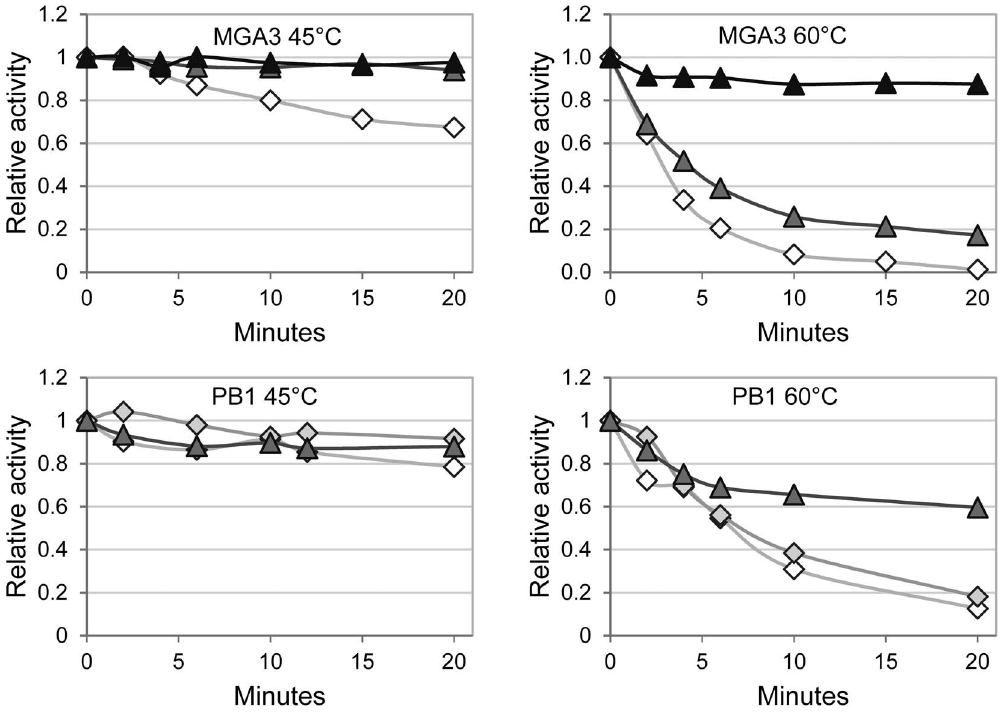
Figure 3. Temperature stability of the MGA3 and PB1 Mdhs. Enzymatic activities of Mdh M /Mdh P (white diamond), Mdh1 P (light grey diamond), Mdh2 M /Mdh2 P (dark grey triangle) and Mdh3 M (black triangle) were measured upon preincubation at 45 u C or 60 u C. Activity without preincubation was for each enzyme arbitrarily set to 1. The results from at least two independent experiments with standard errors below 10%, and mean values are